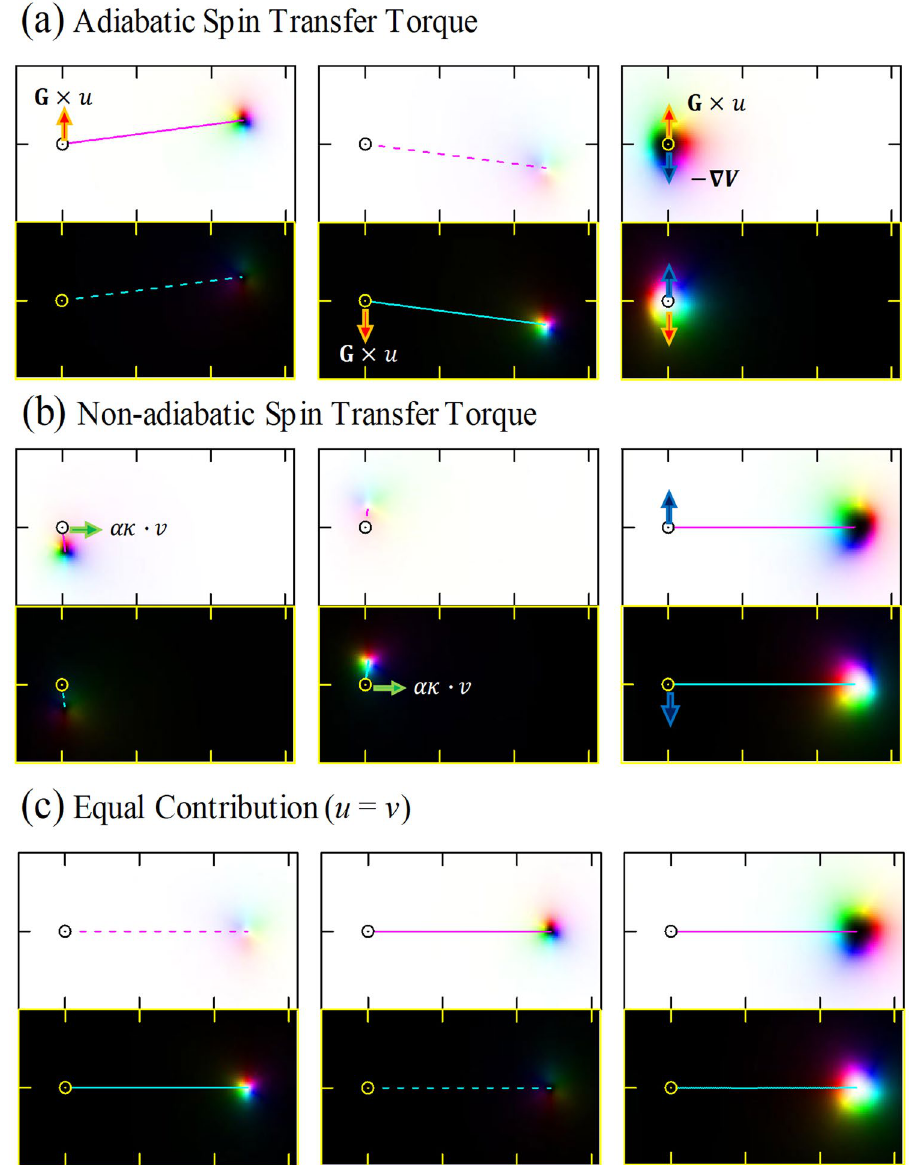
Figure 3. Skyrmion trajectories of ‘Sole skyrmion’ with G = 4 π [left], ‘Sole skyrmion’ with G = 4 π [middle] and ‘Skyrmion pair’[right], at ( a ) identical adiabatic STTs( u 1 = u 2 = u and ν 1 = ν 2 = 0), ( b ) identical non-adiabatic STTs( u 1 = u 2 = 0 and ν 1 = ν 2 = ν ), and ( c ) equal contribution of adiabatic and non-adiabatic STTs ( v = u ). All STTs are along x -direction. Circular dots are for the original position of the magnetic structure in the steady state. Solid lines are the trajectories of skyrmions and dashed lines are those of non-skyrmion magnetic structure. Trajectory lines are obtained by calculating the center of skyrmion. Red arrows denote the force induced by adiabatic STT, green arrows denote the force induced by non-adiabatic STT, and blue arrows denote the force induced by the J int